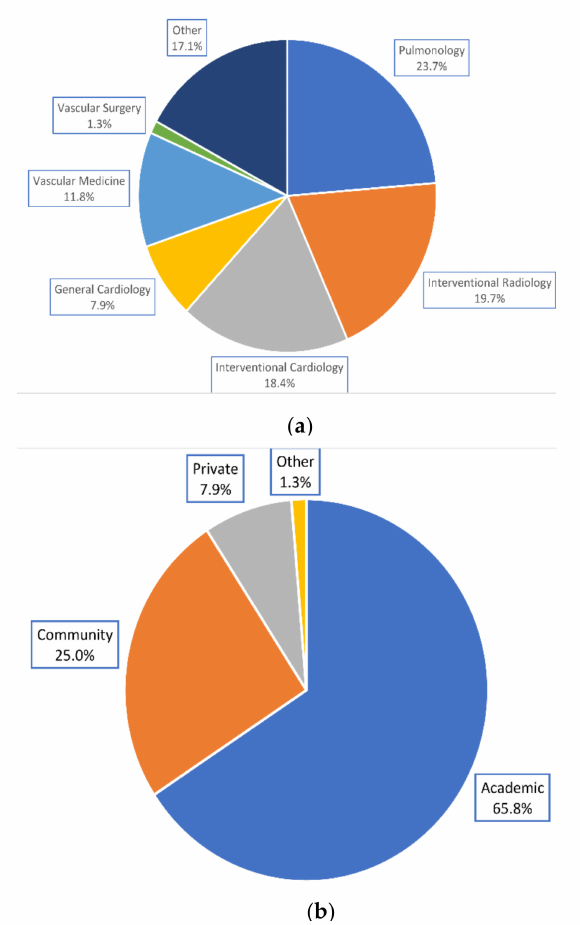
Figure 1. Physicians’ demographics. ( a ) Specialties represented by physicians. ( b ) Practice settings reported by